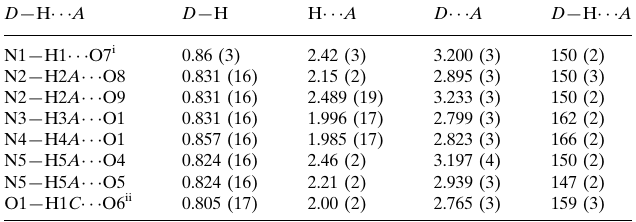
Hydrogen-bond geometry (A˚ , (cid:3) ).